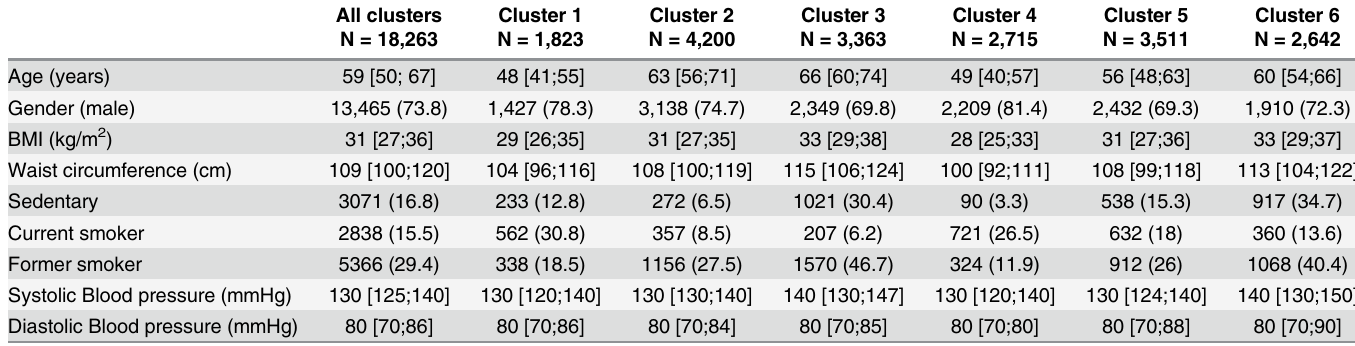
Table 1. Patients characteristics of the entire cohort and by clusters: Anthropometric and demographic characteristics. Values in Numbers (%) or median [IQR]. Body Mass Index (BMI). Cluster 1: the young symptomatic. Cluster 2: the old obese. Cluster 3: the multi-disease (MD) old obese. Cluster 4: the young snorers. Cluster 5: the drowsy obese. Cluster 6: the MD obese symptomatic.